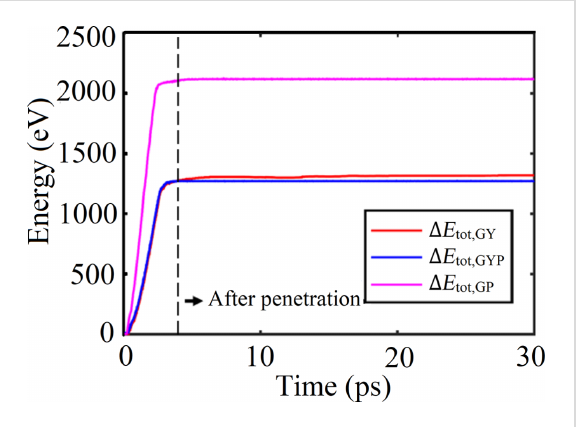
Figure 2: Energy change as a function of the time for an α -GY nano- sheet under an impact velocity of 2 km/s. ∆ E tot,GY and ∆ E tot,GYP repre- sent the total energy change of α -GY nanosheet and the projectile, re- spectively.